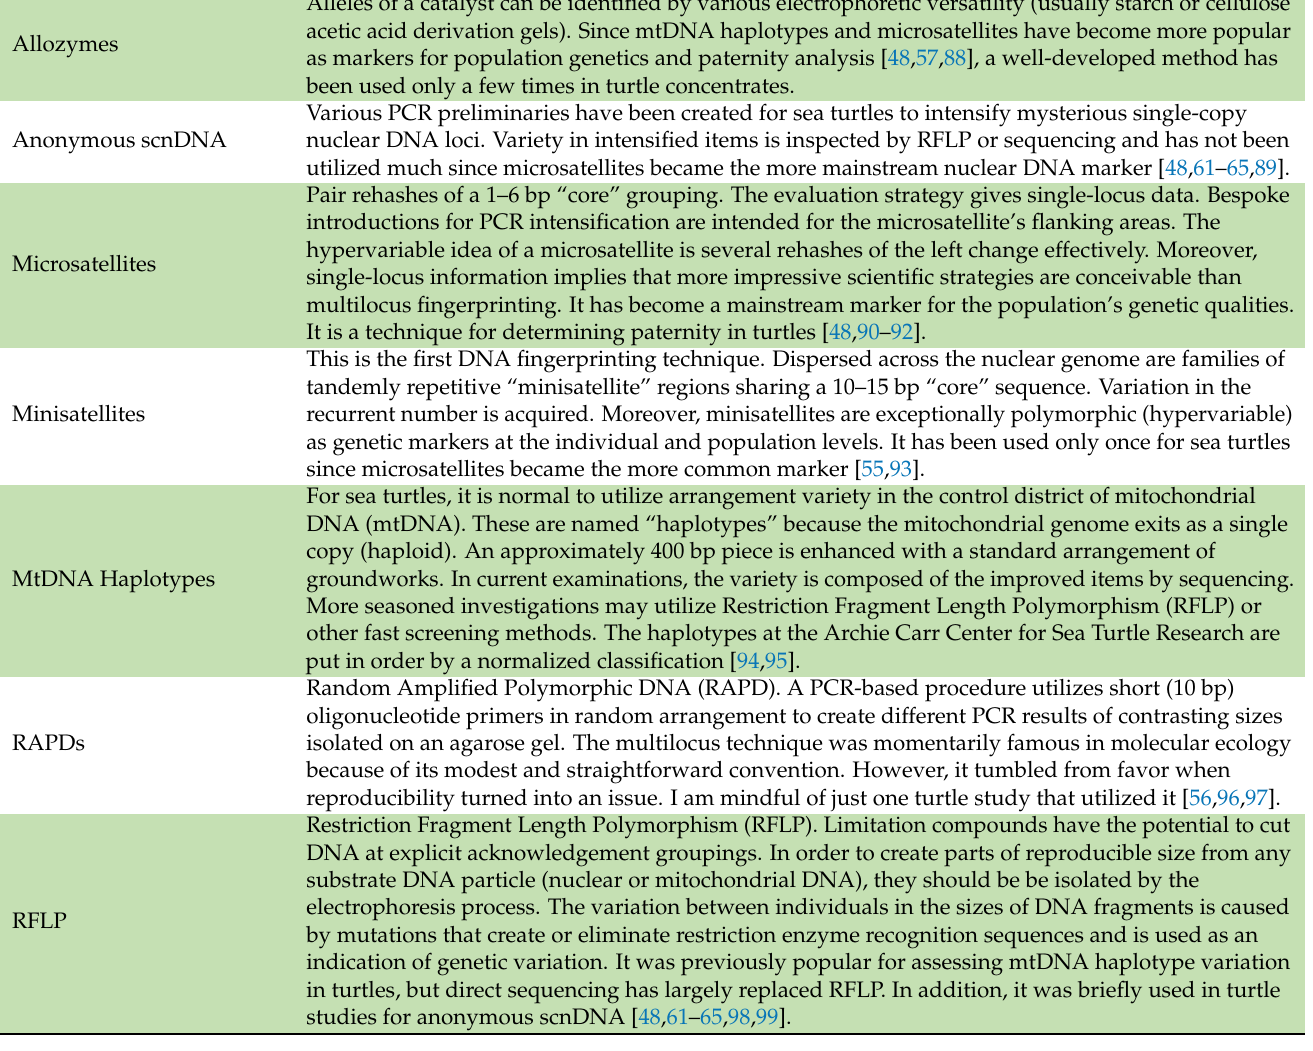
Table 1. Genetic markers for molecular turtle